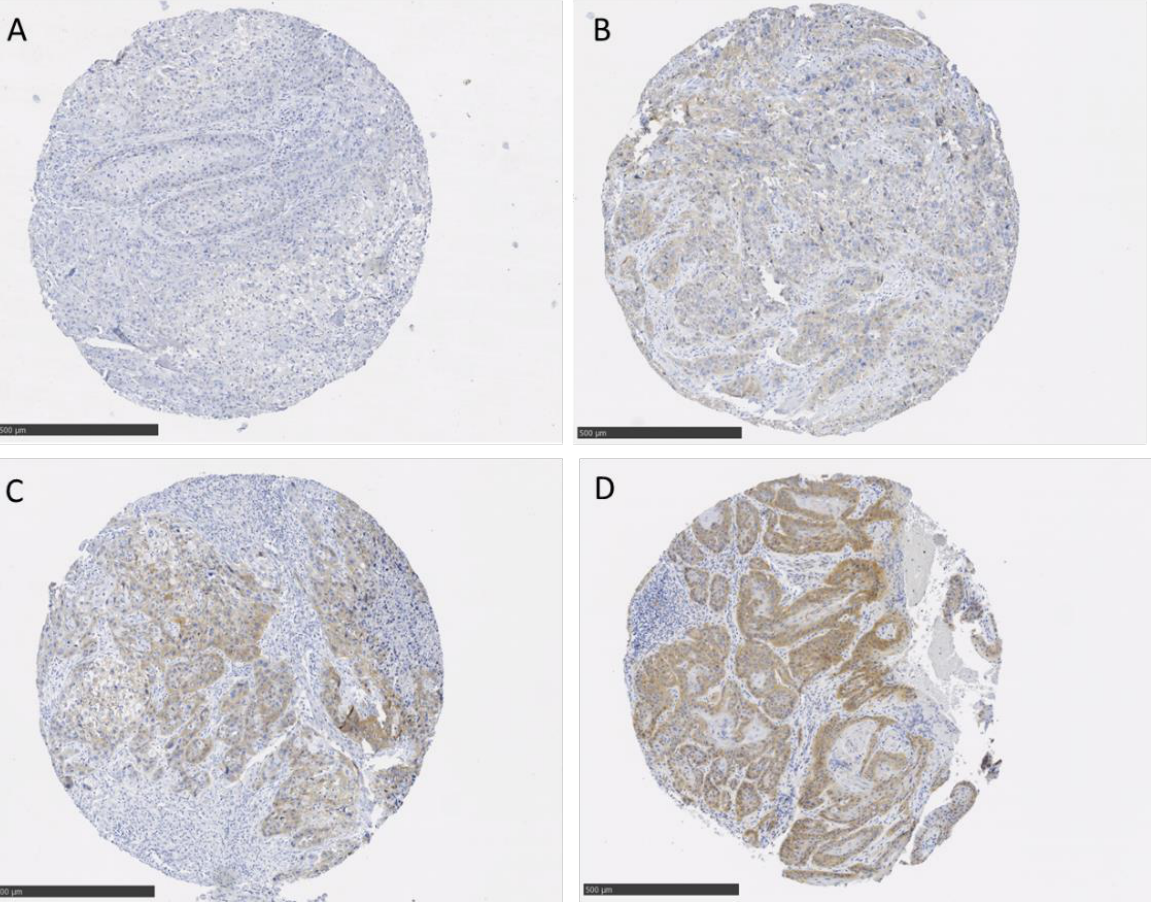
Figure 1. Representative immunohistochemical images of PeCa TMA tissue stained with c-MET antibody including different intensity scores of 0 ( A ), 1 ( B ), 2 ( C ), and 3 ( D ); scale bar = 100 µm. In univariate analysis, there were no significant associations between the protein expression level of the biomarker candidates c-MET, n-myc, PPARg, and snail and clinico- pathological features. In contrast to β -catenin, there was no association between c-MET or PPARg expression and HPV infection (Supplemental Figure